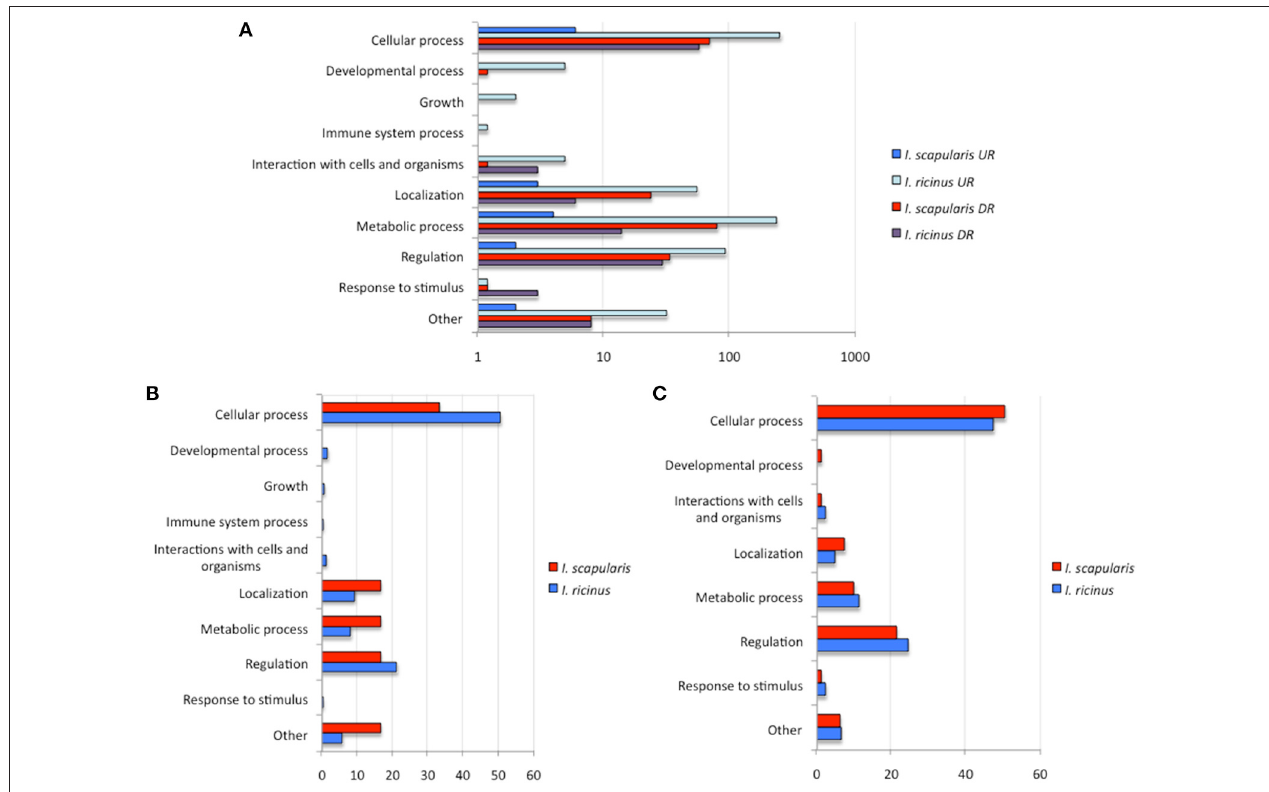
FIGURE 2 | Biological processes affected by A. phagocytophilum infection of I. ricinus IRE/CTVM20 and I. scapularis ISE6 cells. (A) Differentially expressed genes were functionally annotated and grouped according to the BP of the encoded proteins. The number of genes on each BP is shown. (B) Percentage of upregulated genes in each BP. (C) Percentage of downregulated genes in each BP. UR, upregulated genes; DR, downregulated genes.